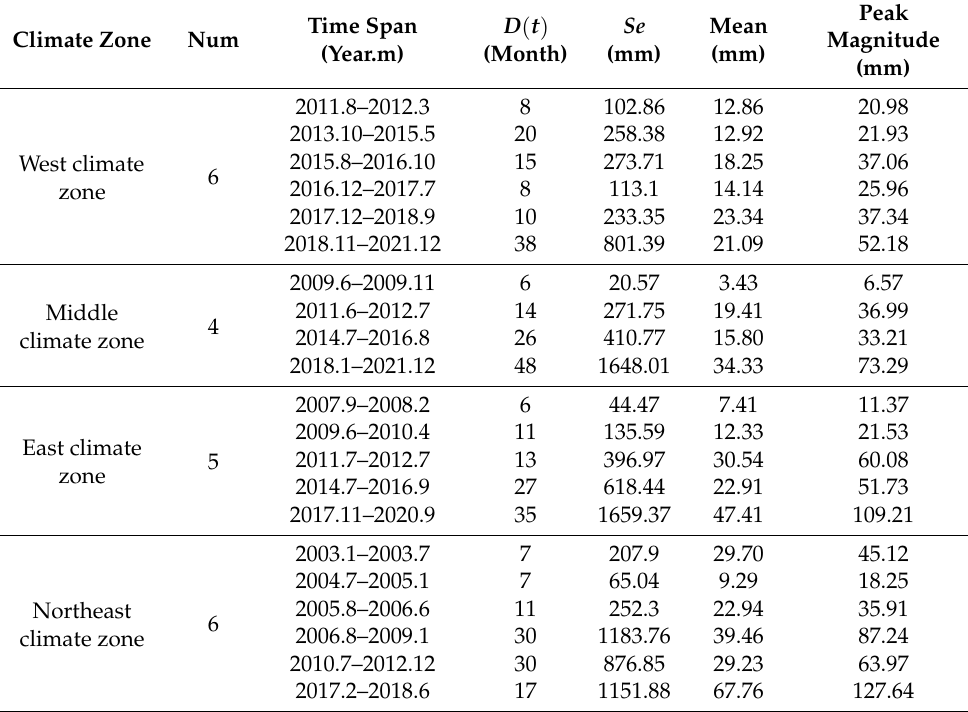
Table 2. Summary table of hydrological drought events identified by